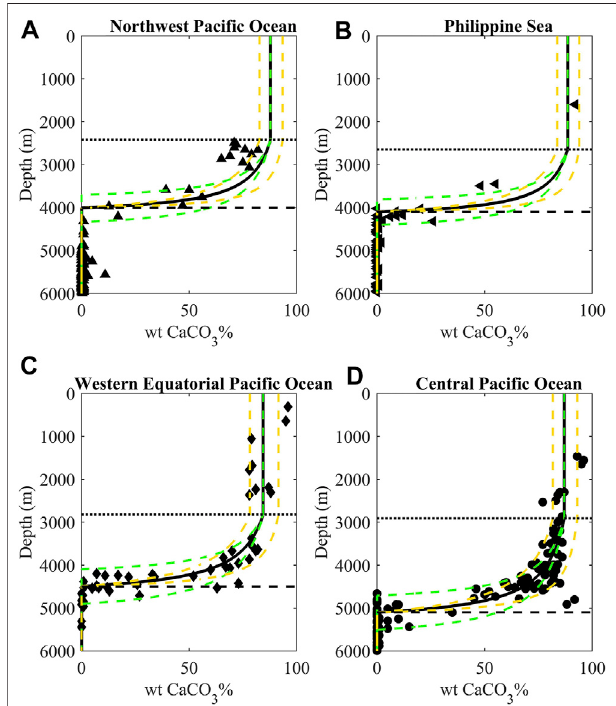
FIGURE 3 | Pelagic sedimentary wt CaCO 3 %-depth pro fi les and model outputs for the Northwest Paci fi c Ocean (A) , Philippine Sea (B) , Western EquatorialPaci fi cOcean (C) ,andCentralPaci fi cOcean (D) .Predictionsbythe model ’ s control run ( Table 1 ) are shown by bold black lines. The sensitivity tests with observed position of carbonate compensation depth (±400 m, with corresponding uncertainty of the carbonate dissolution rate k*) and non-carbonate fl uxes F M (±50%) are presented by green and golden dashed lines, respectively. The carbonate saturation depth (CSD) and carbonate compensation depth (CCD) are indicated by the black dotted and dashed lines,